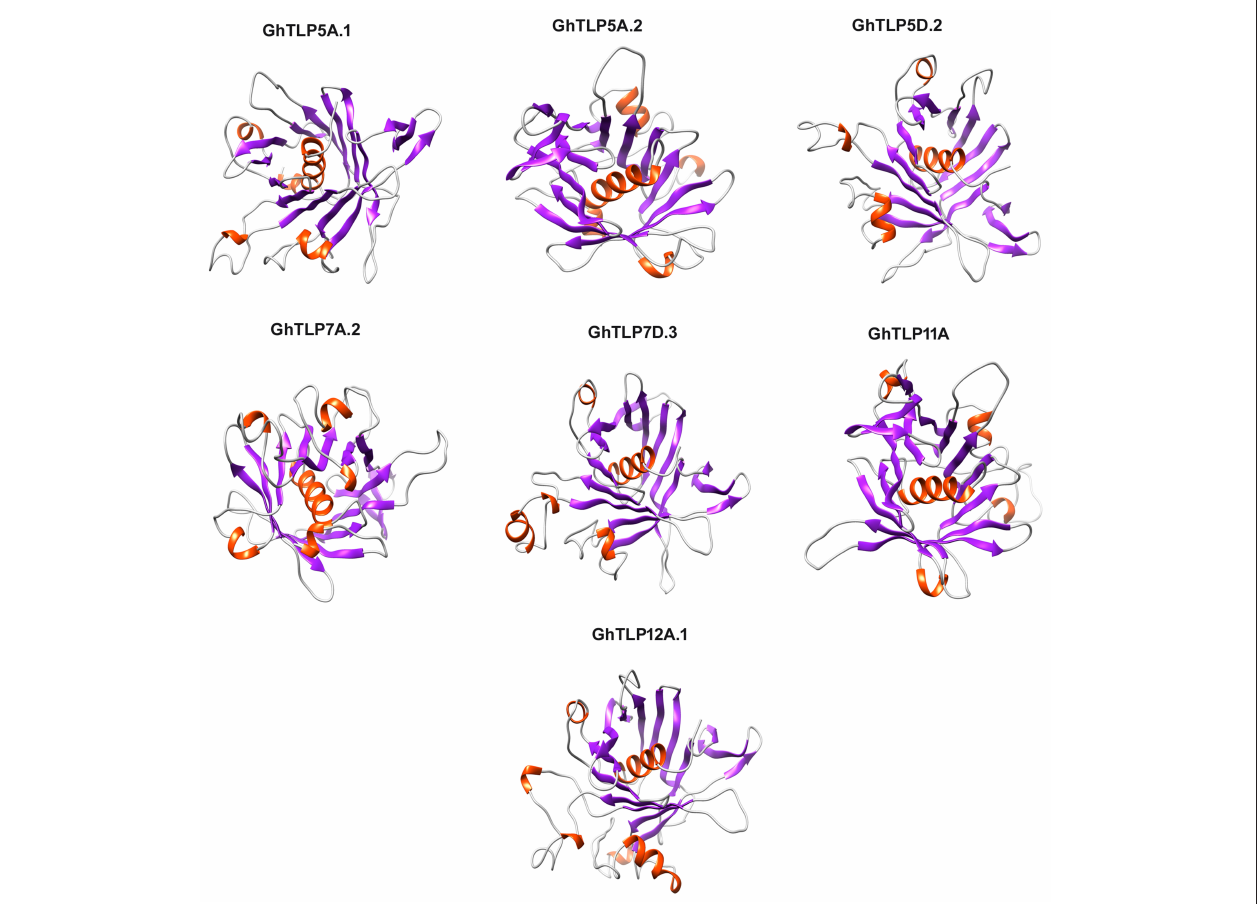
FIGURE 7 | The homology 3D model of the GhTLPs tubby domain. The GhTLPs were selected for three-dimensional structure prediction and display with confidence level > 99%. The alpha helix is shown with red and beta fold is shown with violet